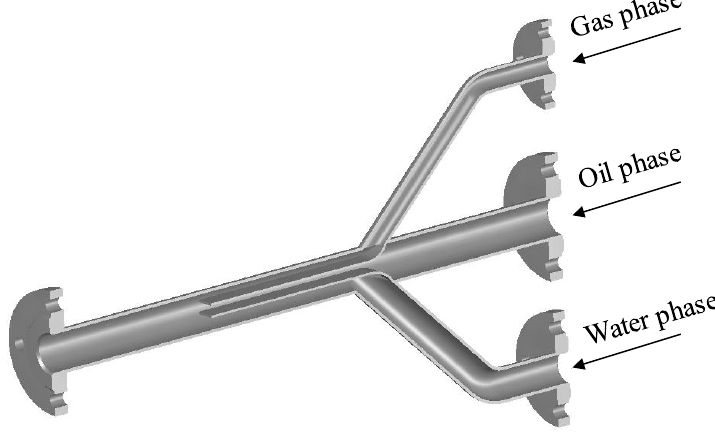
Figure 2. Schematic of the double-Y junction fitting mixer.